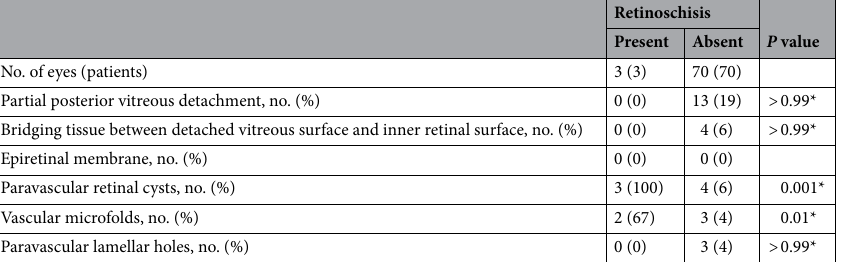
Table 3. Comparison of UWF-OCT findings of vitreous and retina in highly myopic young patients with and without retinoschisis. *Fisher’s exact probability test.